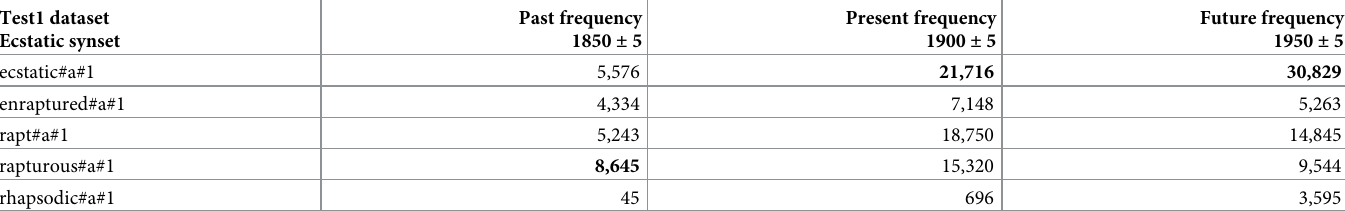
Table 2. A sample of the Test1 dataset entries for the rapturous–ecstatic synset. The highest frequencies for each time period are marked in bold, indicating the winners.